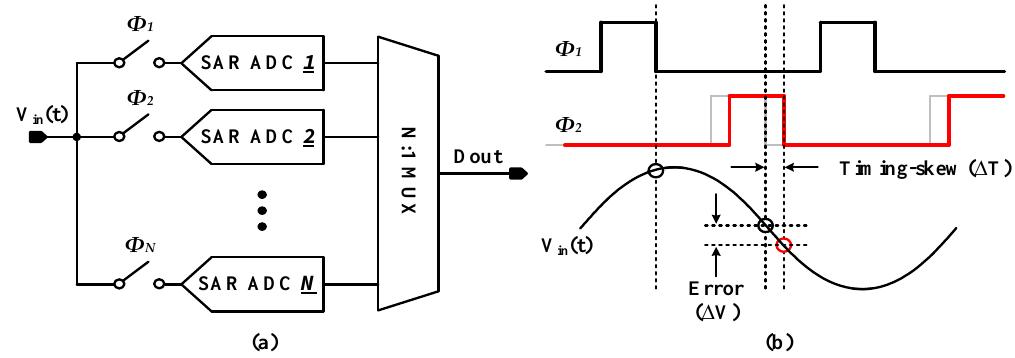
Figure 1. ( a ) Basic structure of a time-interleaved successive approximation register analog-to-digital converters (SAR ADC) and ( b ) timing-skew error in a time-interleaved SAR ADC.